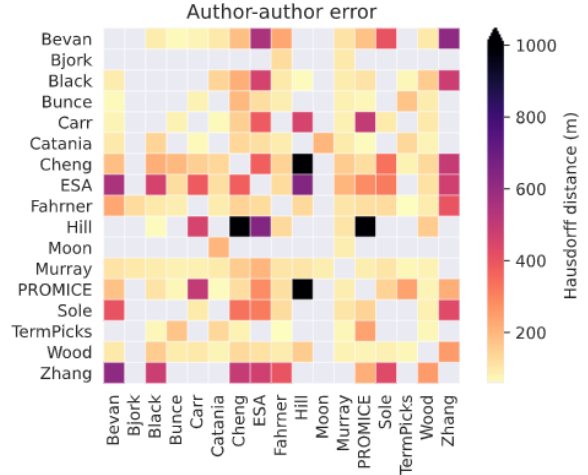
Figure 12. Median error between pairs of authors, for instances where those authors have duplicated a glacier trace on a given date. No color indicates two authors have no duplicated traces between